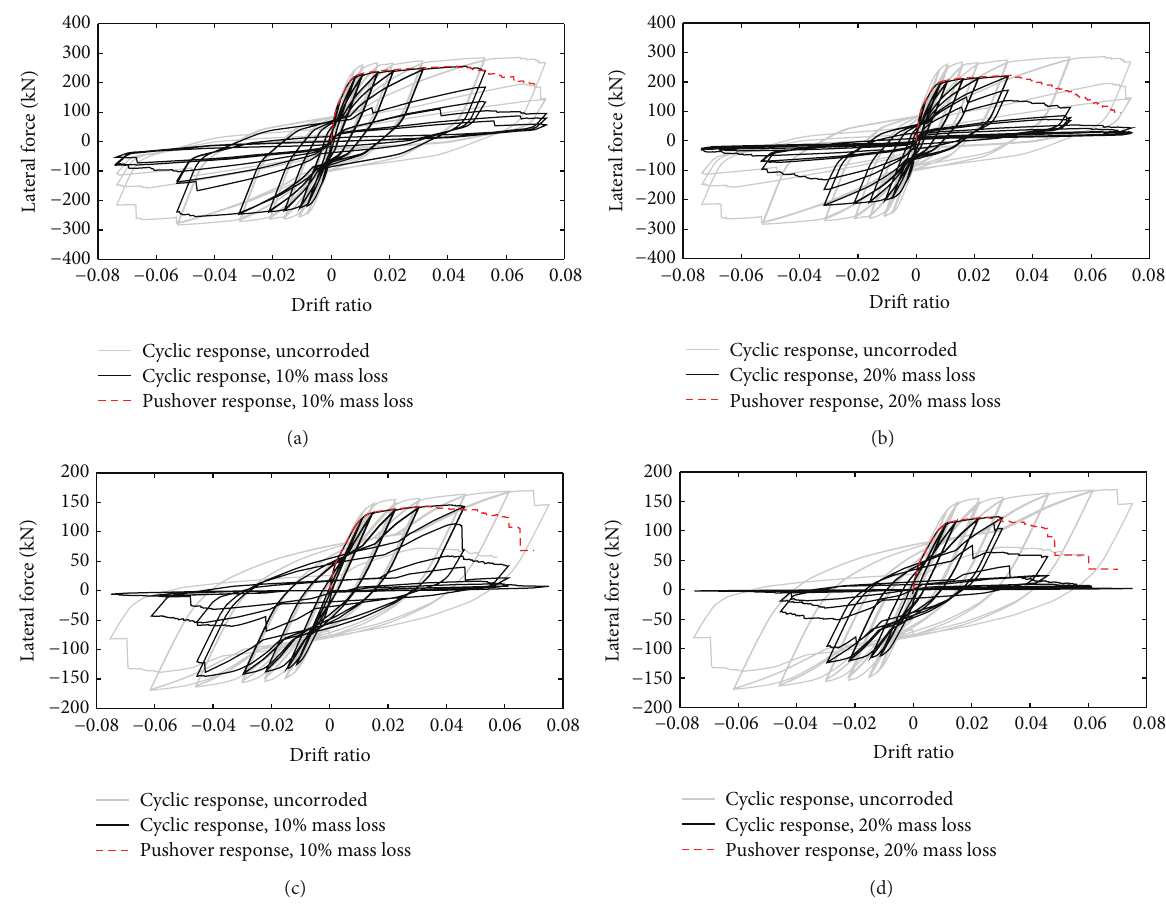
Figure 13: Cyclic analyses considering corrosion induced damage in reinforcing steel, cracked cover concrete, and confined concrete: (a) and (b) Lehman’s column 415; (c) and (d) Moyer and Kowalsky’s column